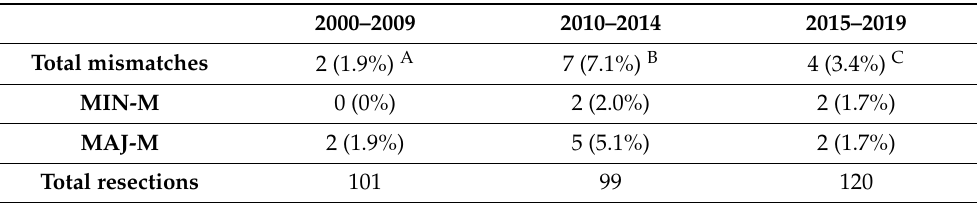
Table 4. Mismatches over resection